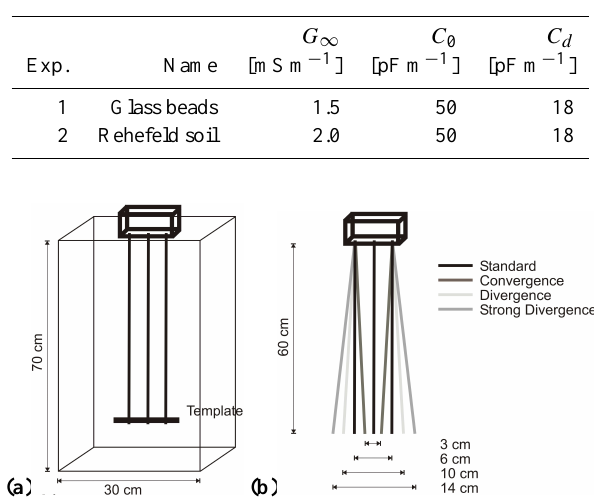
Fig. 3. Sketch of the plastic box with installed SUSU03 and position of the wooden template (a) , and sketch of the four different probe geometries (b) .